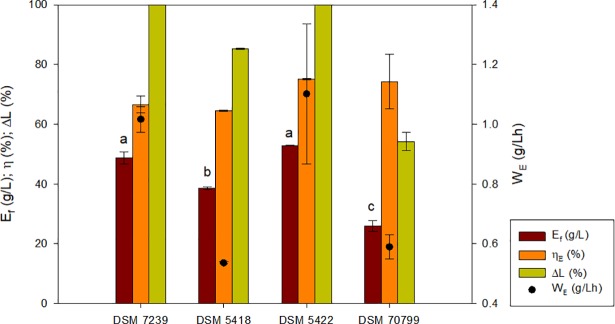
Fermentation performance of K. marxianus DSM 7239, DSM 5418, DSM 5422 and DSM 70799 in concentrated synthetic medium (Li = 130 g/L).Parameters: final ethanol concentration (Ef), ethanol yield conversion efficiency (ηE), lactose consumption (ΔL) and productivity (WE). The different letters above ethanol bars (a, b, c) indicate the existence of significant differences (p < 0.05) among strains for ethanol production. If two strains share one letter, there are no significant differences between them.